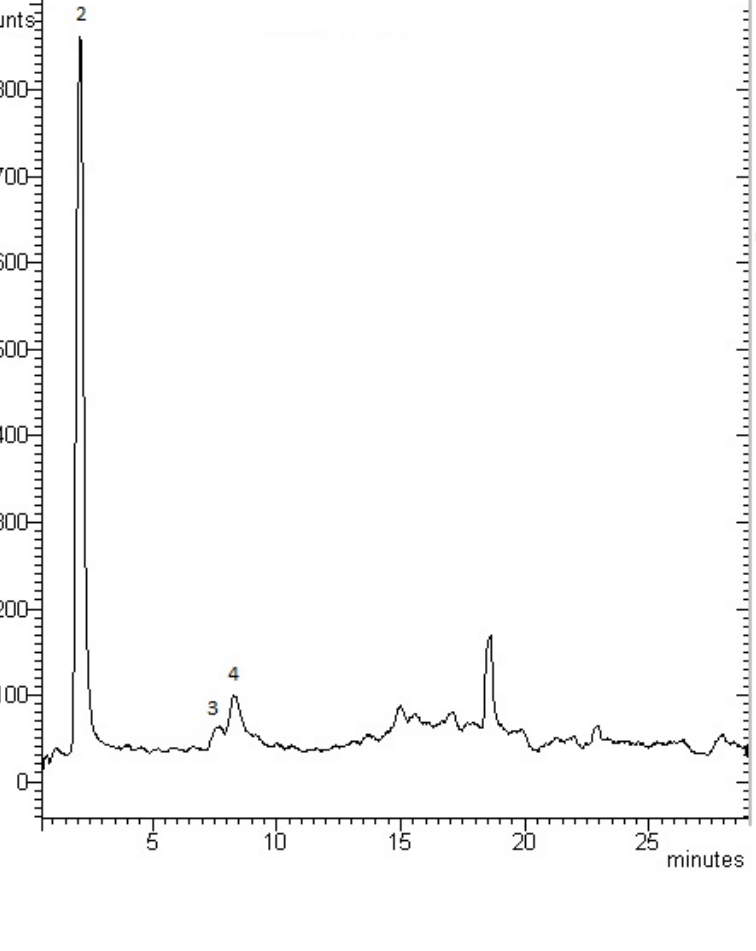
Figure 3. Chromatogram of seawater sample from Las Palmas de Gran Canaria outfall with LC-MS/MS detection: 2-Acetaminophen; 3-Norfloxacin;